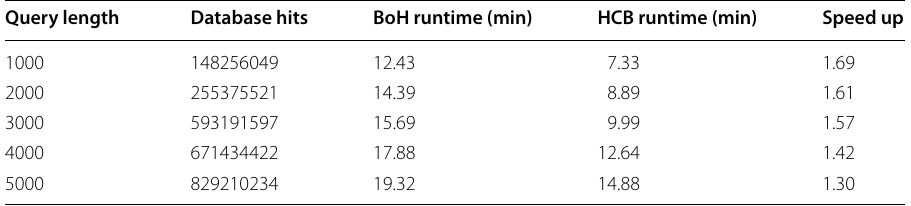
Table 1 Performance of HCudaBLAST compared to generic BLAST algorithm on Hadoop with 2M sequences (BoH: BLAST on Hadoop, HCB: HCudaBLAST) Query length